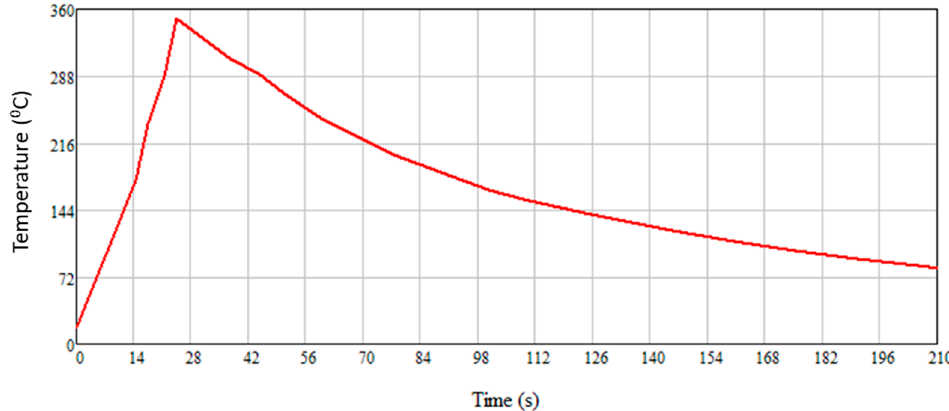
Figure 4. The time variation of the maximum temperature on the convex face of the shield when it was exposed to an open flame. was exposed to an open